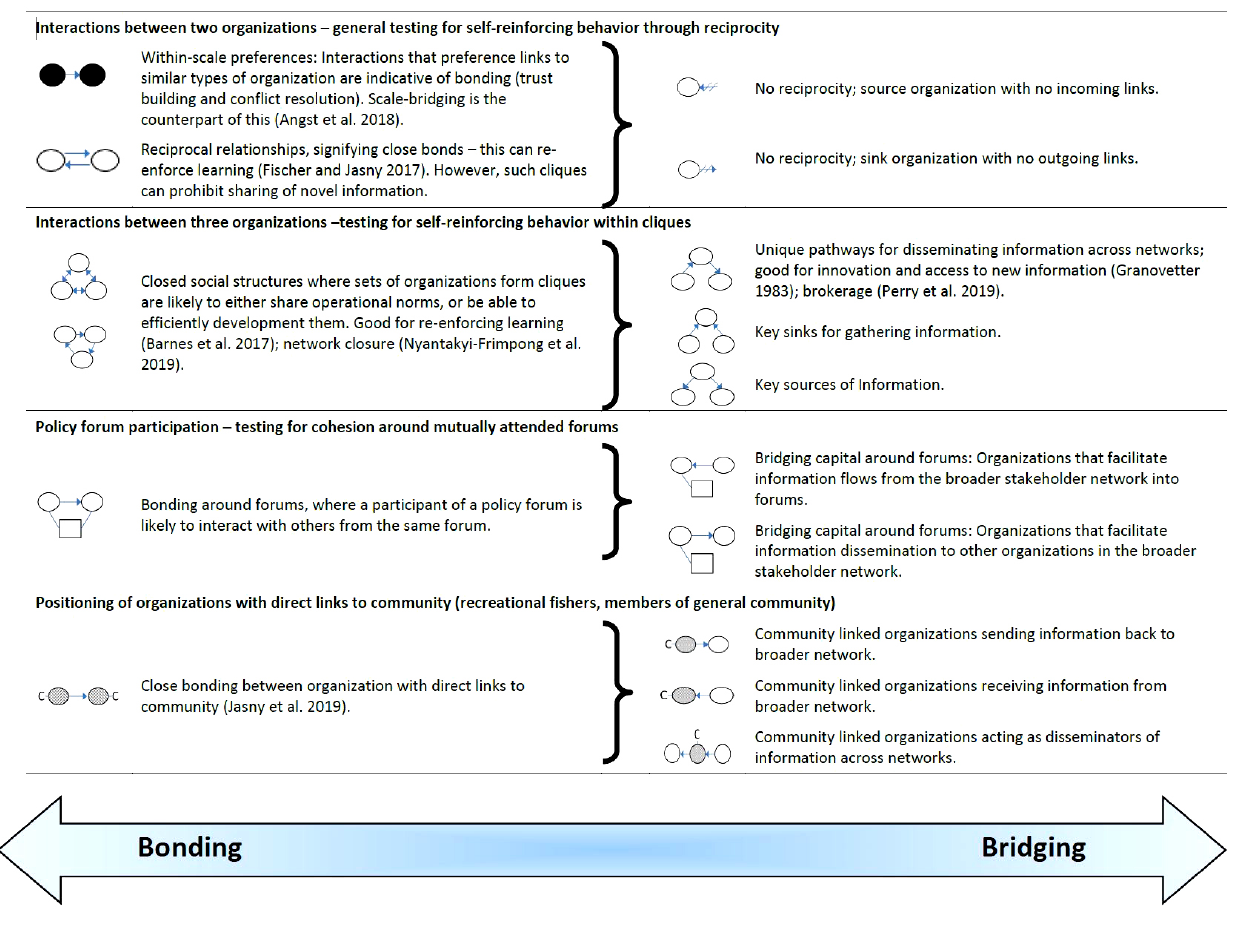
Fig. 3 . Selection of network configurations of theoretical interest. References suggest recent